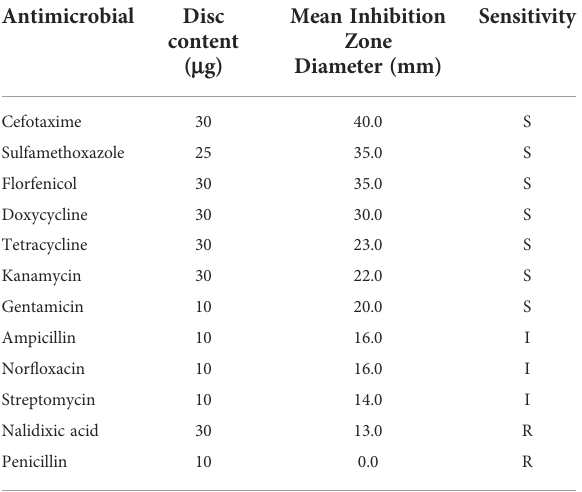
TABLE 3 Antibiotic susceptibility pro fi les of isolated S. putrefaciens. . Antimicrobial